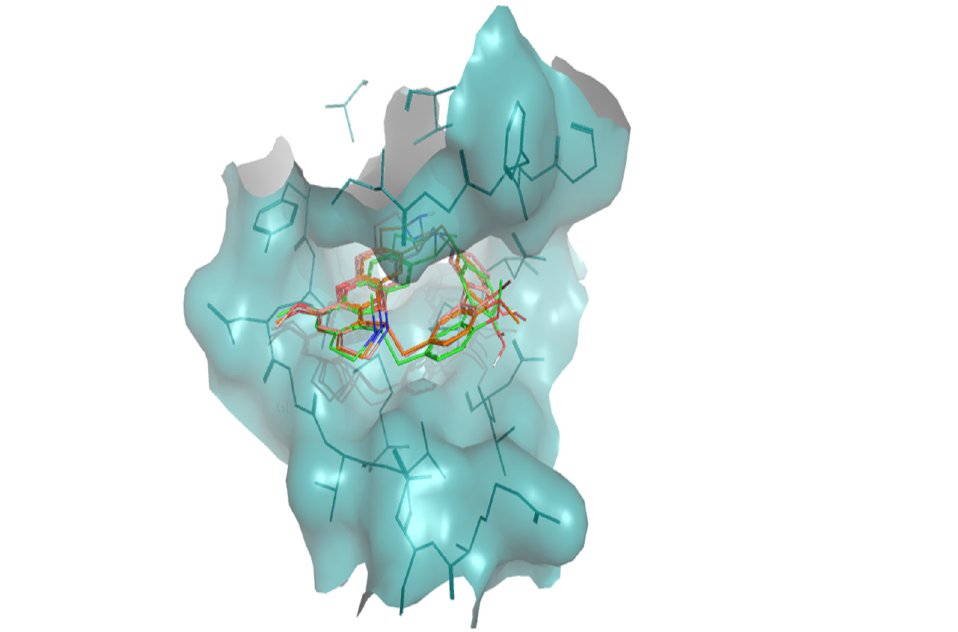
Figure 6. Molecular interactions of the best docking position of α -cubebin against Pks13. Hydrogen bonds are evidenced with yellow dashed lines.